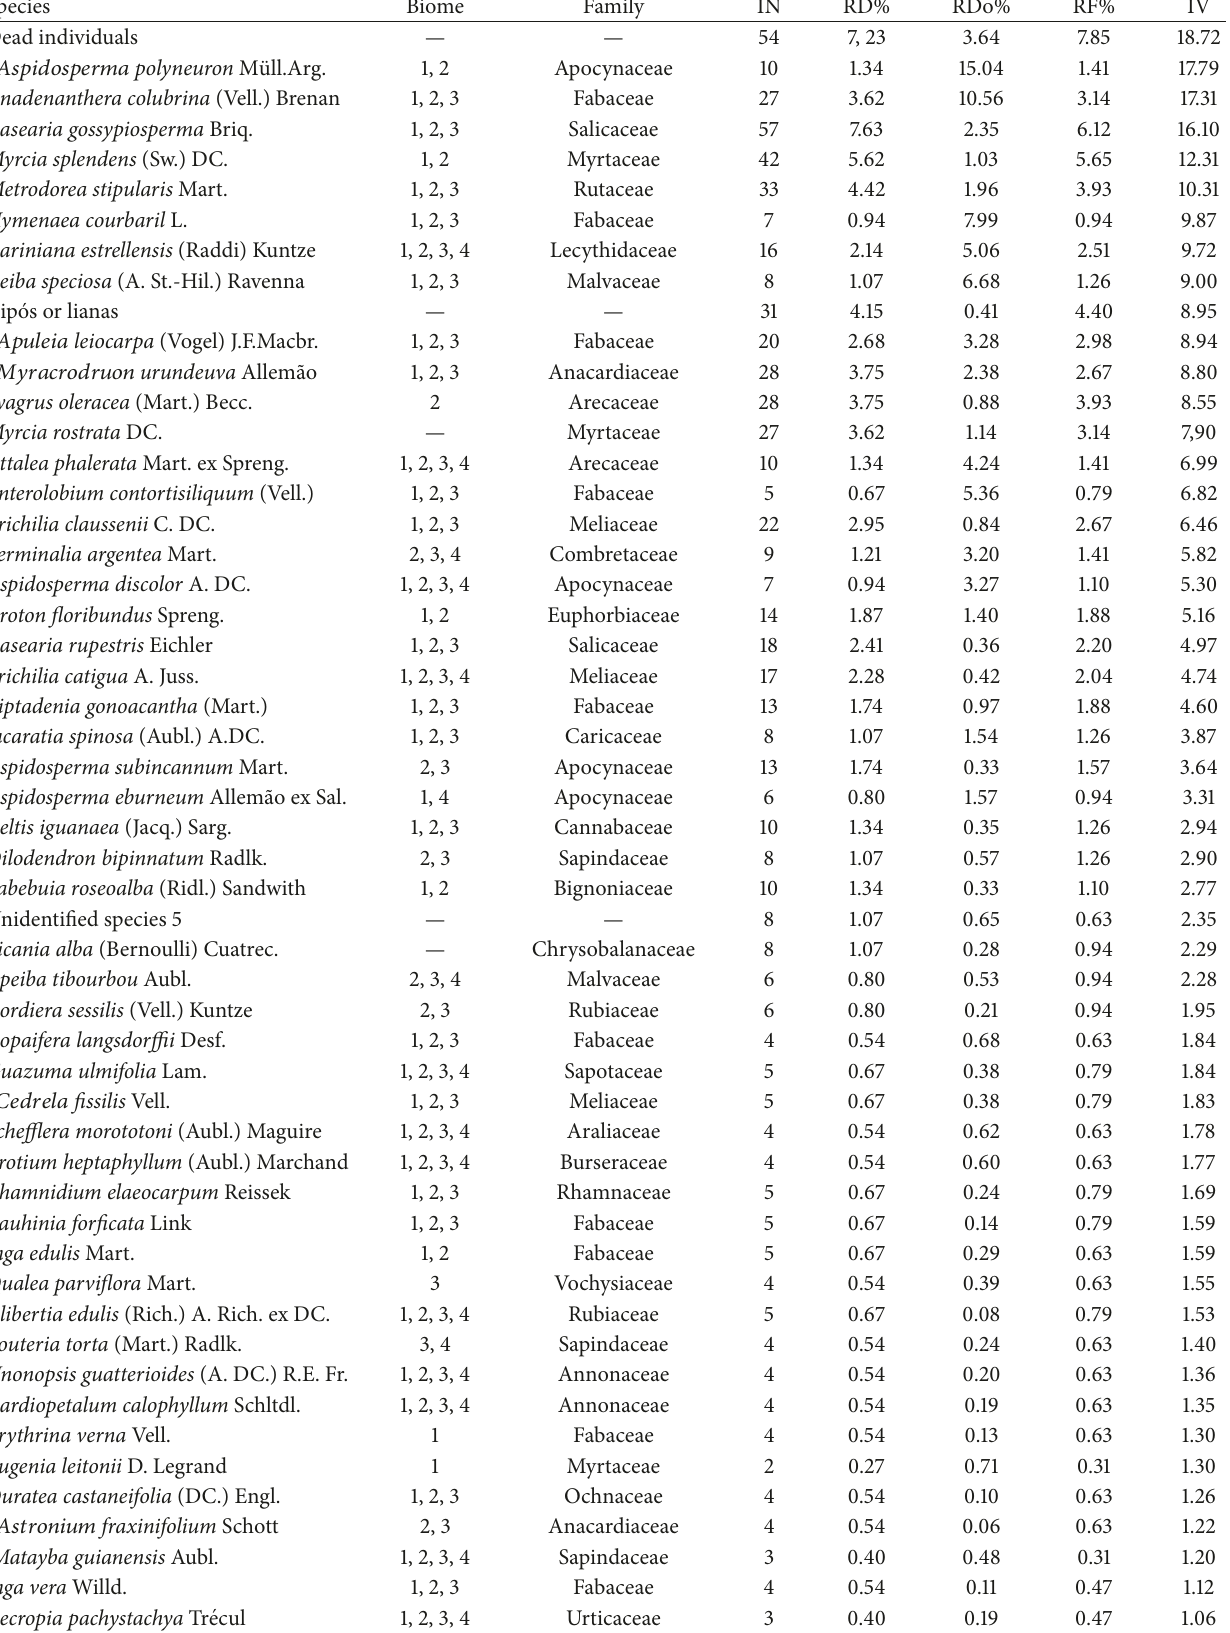
Table 1: Phytosociological features of Parque Estadual Mata Atlˆantica (PEMA),